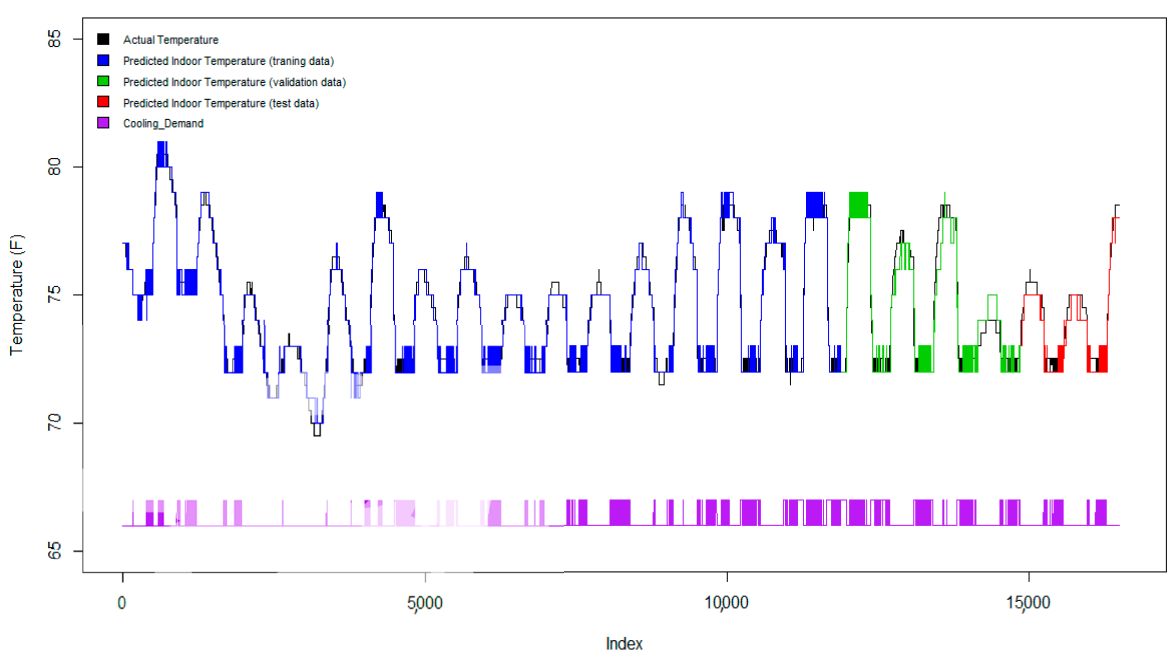
Figure 3. Actual temperature versus predicted temperature for the whole dataset using an LSTM model obtained using the indoor relative humidity and moving averages as features. Table 5. Validation matrices for all residences’ models.